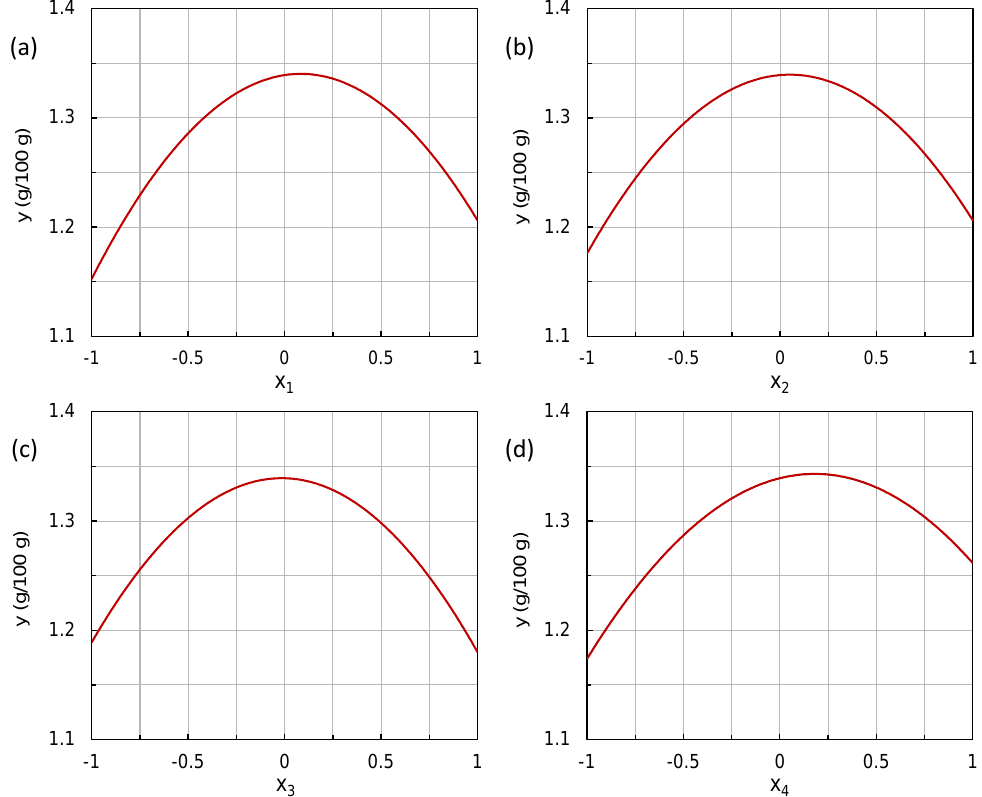
Figure 4. Perturbation plots for the four factors: ( a ) enzyme dosage; ( b ) incubation time; ( c ) liquid-to-solid ratio and ( d ) ethanol concentration. y is the flavonoid extraction yield and x i is the coded level of factor i. Each diagram was plotted by keeping the levels of the other three factors at their central values.